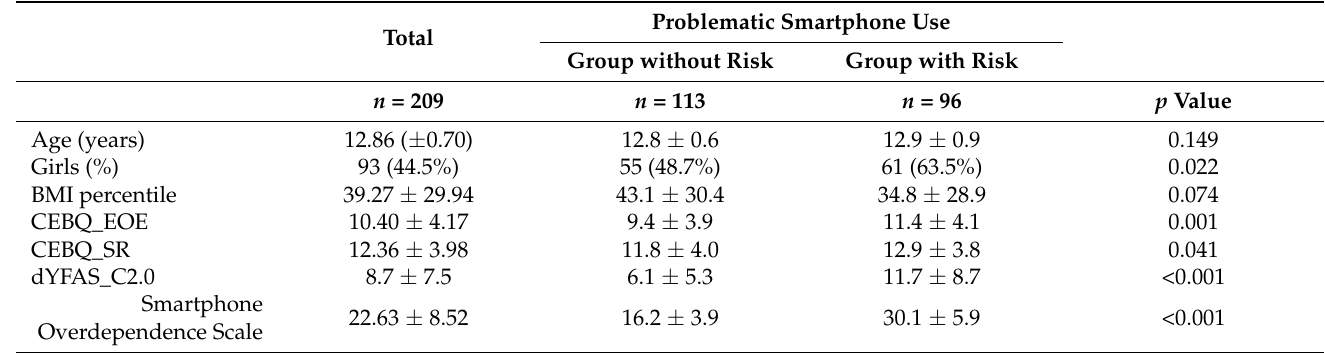
Table 2. The comparison between eating behaviors and food addiction in a group with problematic smartphone use risk. Problematic Smartphone Use Total Group without Risk Group with Risk